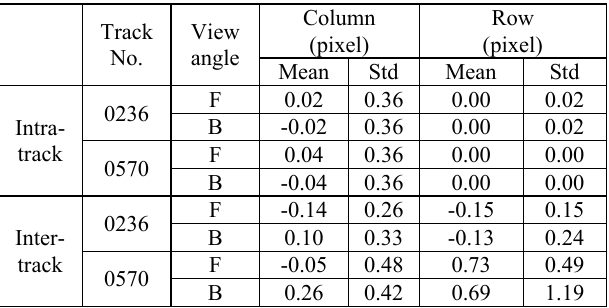
Table 2.Back-projection residuals after